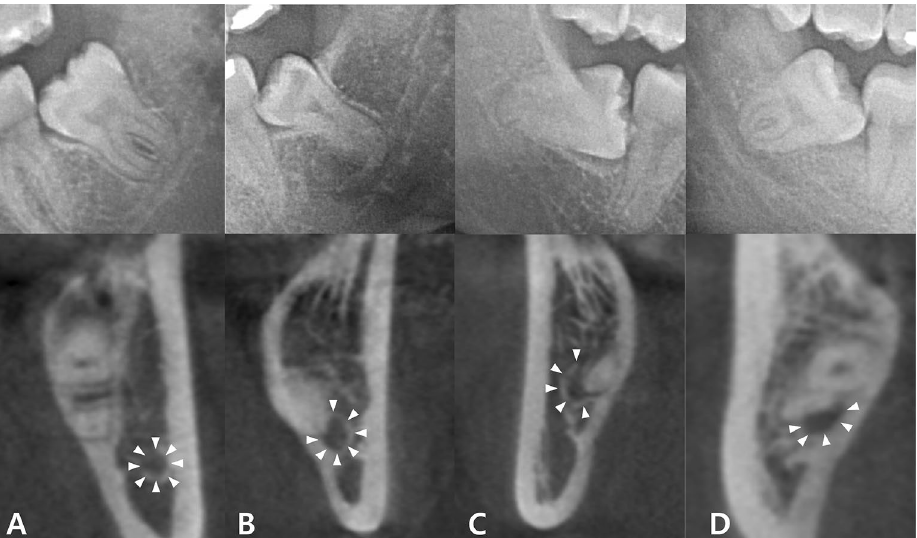
Figure 1. Classification of panoramic images based on CBCT. The M3 and IAN seemed to be superimposed in four panoramic images. White triangles point to the border of the IAN in CBCT. ( A ) Intimate but non-contact positioning between M3 and IAN. ( B ) True contact positioning between M3 and IAN. ( C ) IAN positioned buccal to M3. ( D ) IAN positioned lingual to M3. CBCT cone-beam computerized tomography, M3 mandibular third molar, IAN inferior alveolar nerve.